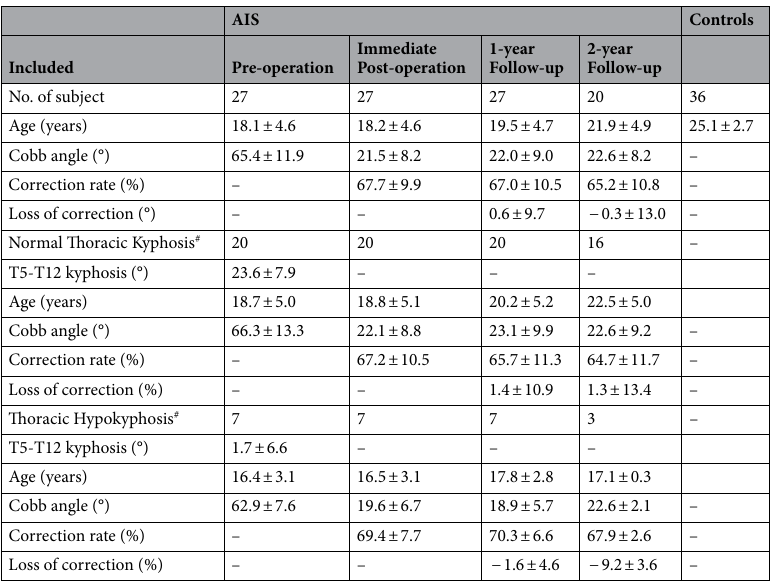
Table 1. Demographic Characteristics are shown for all included adolescent idiopathic scoliosis (AIS) and controls. Data expressed as mean ± SD. # The values are based on the number of subjects, with the percentage in parentheses.